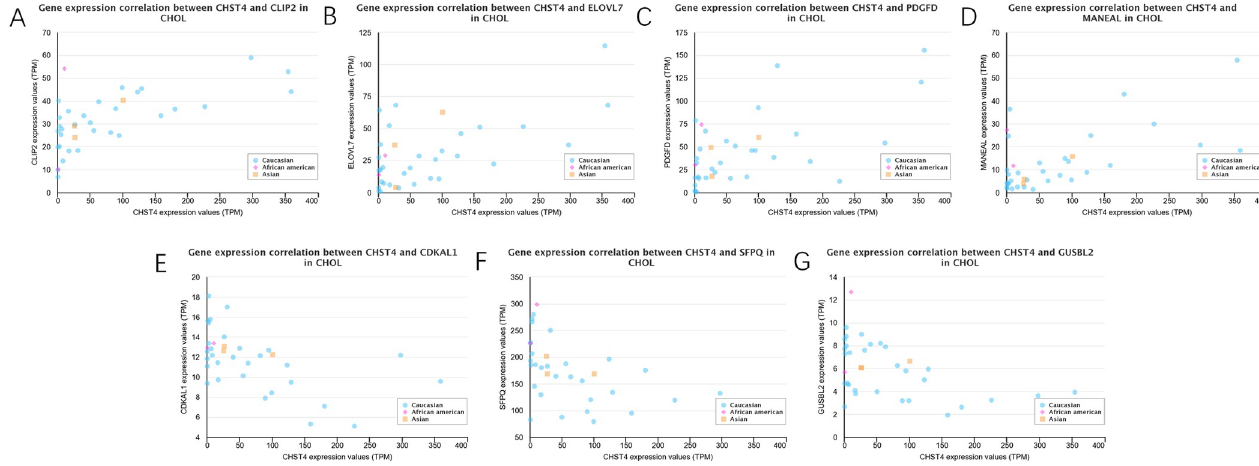
Fig 3. Scatter plot of gene expression correlation from the UALCAN. (A) gene expression correlation between CHST4 and CLIP2 in CCA, (B) gene expression correlation between CHST4 and ELOVL7 in CCA, (C) gene expression correlation between CHST4 and PDGFD in CCA, (D) gene expression correlation between CHST4 and MANEAL in CCA, (E) gene expression correlation between CHST4 and CDKAL1 in CCA, (F) gene expression correlation between CHST4 and SFPQ in CCA, (G) gene expression correlation between CHST4 and GUSBL2 in